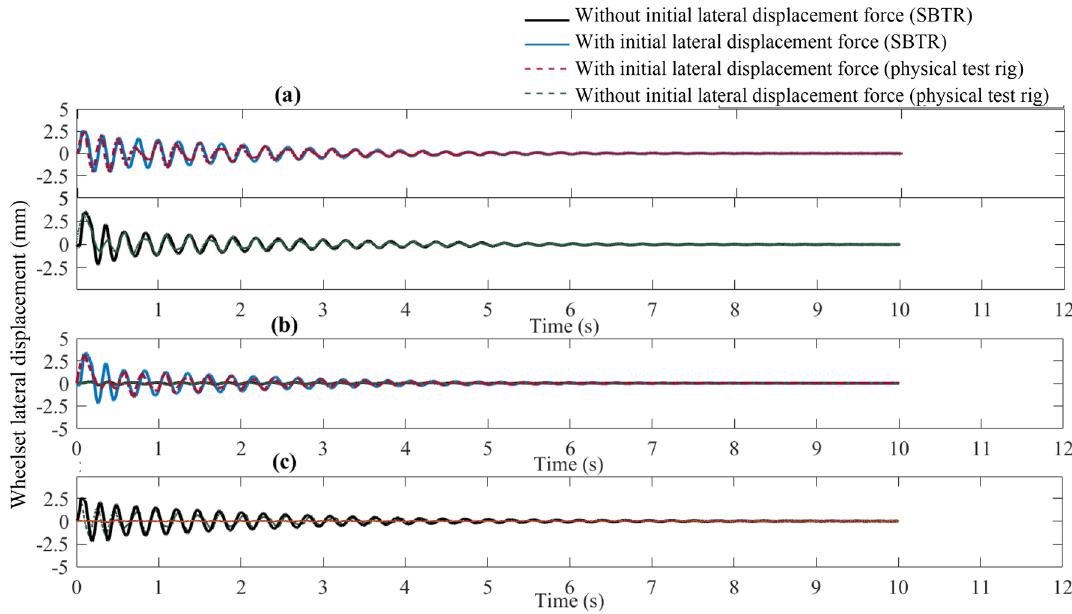
Fig. 7 Lateral displacement on wheelset at 35 km/h with 850 N external lateral force applied on a both wheelsets, b rear wheelset, and c front